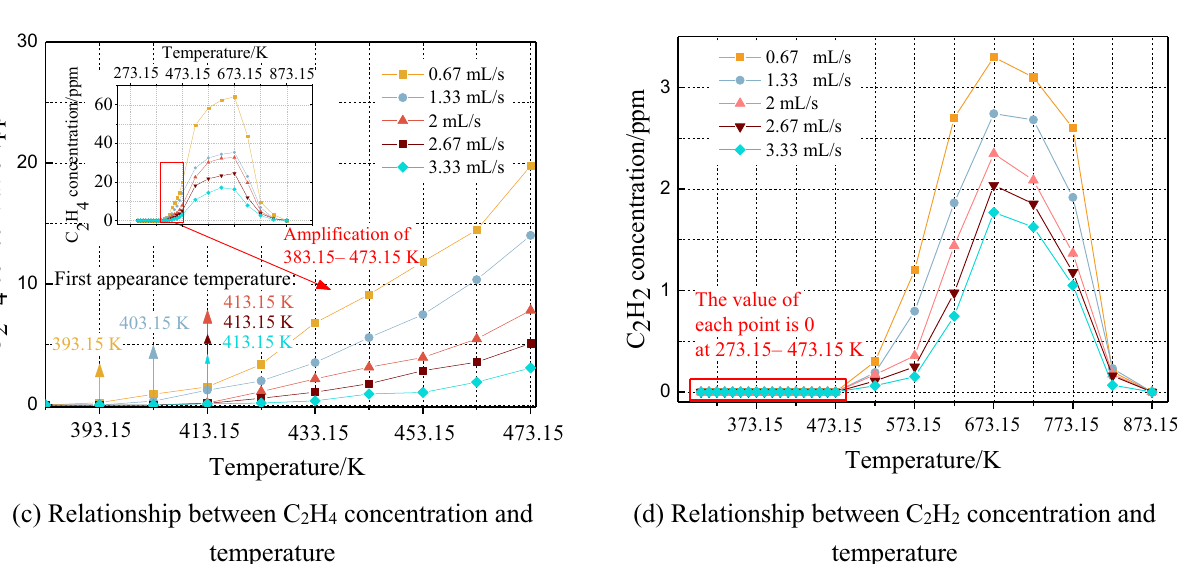
Figure 3. Relationship between gas concentration and temperature under an air volume rate range of 0.67– 3.33